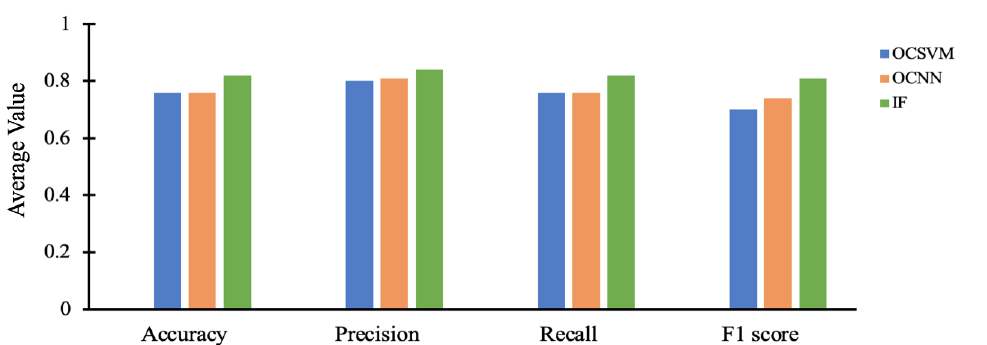
Figure 11. Average test sets 4–5 performance of OCSVM, OCNN, and